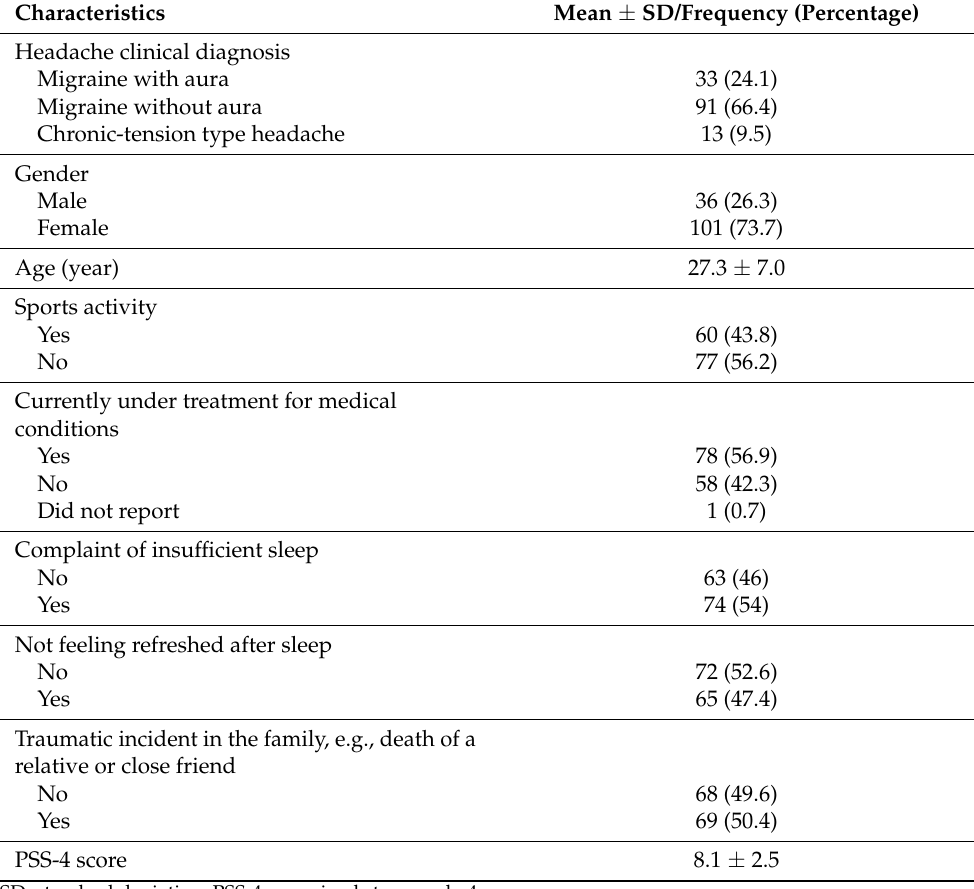
Table 1. Characteristics of participating headache/migraine patients with family history of migraine.